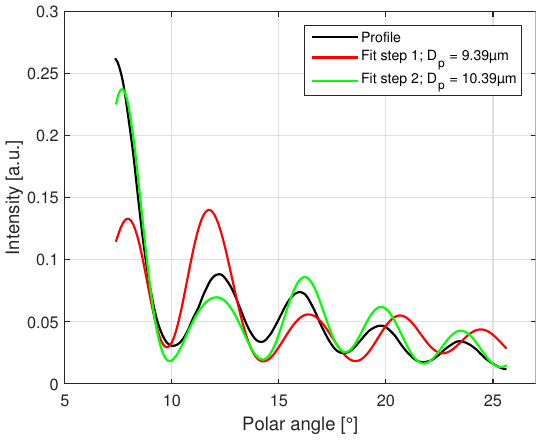
Figure 3. Azimuthal integrated polar intensity of the cloud droplet displayed in Fig. 1a. The two computations of Mie solutions given by the fit routines are displayed as well.